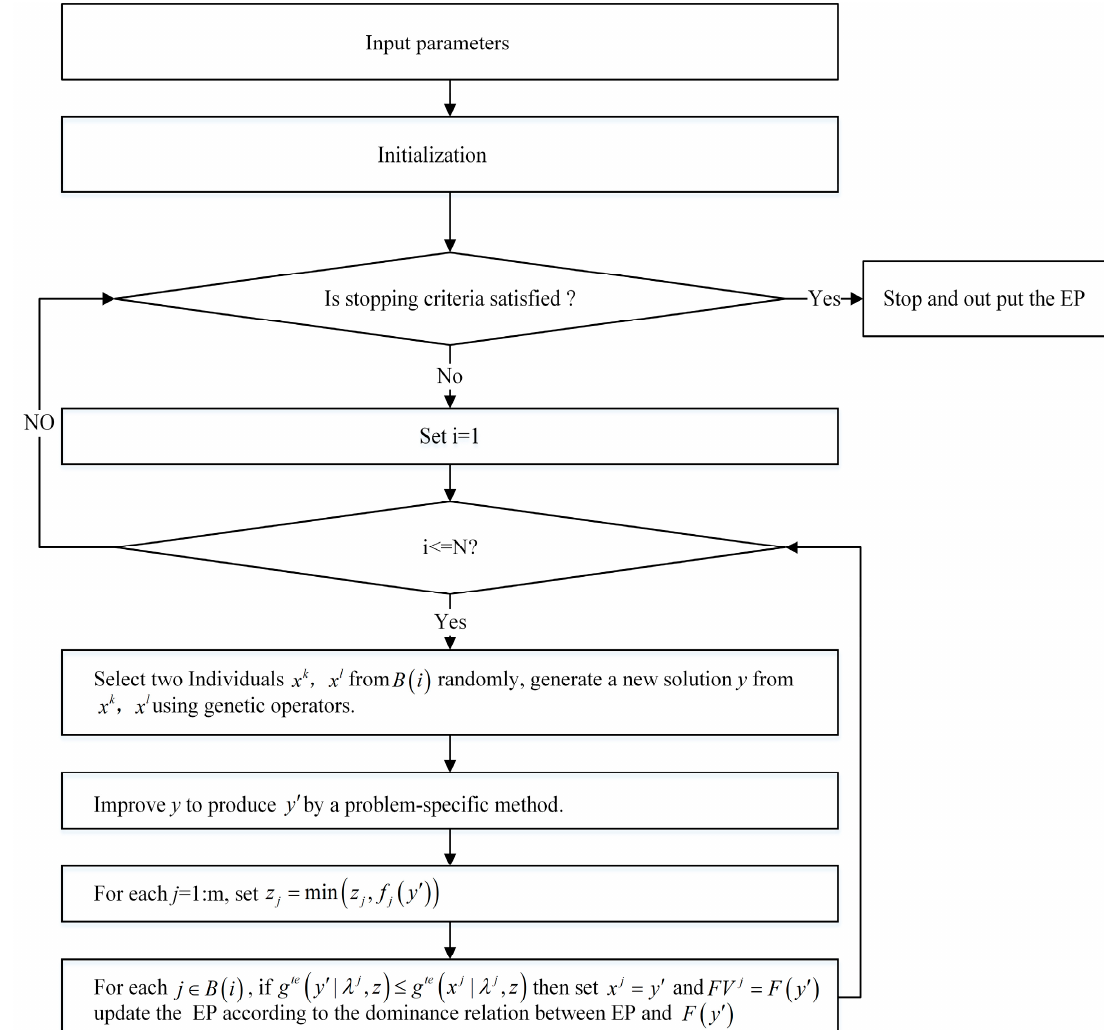
Figure 2. The flow chart of Multi-Objective Evolutionary Algorithm based on Decomposition (MOEA/D).